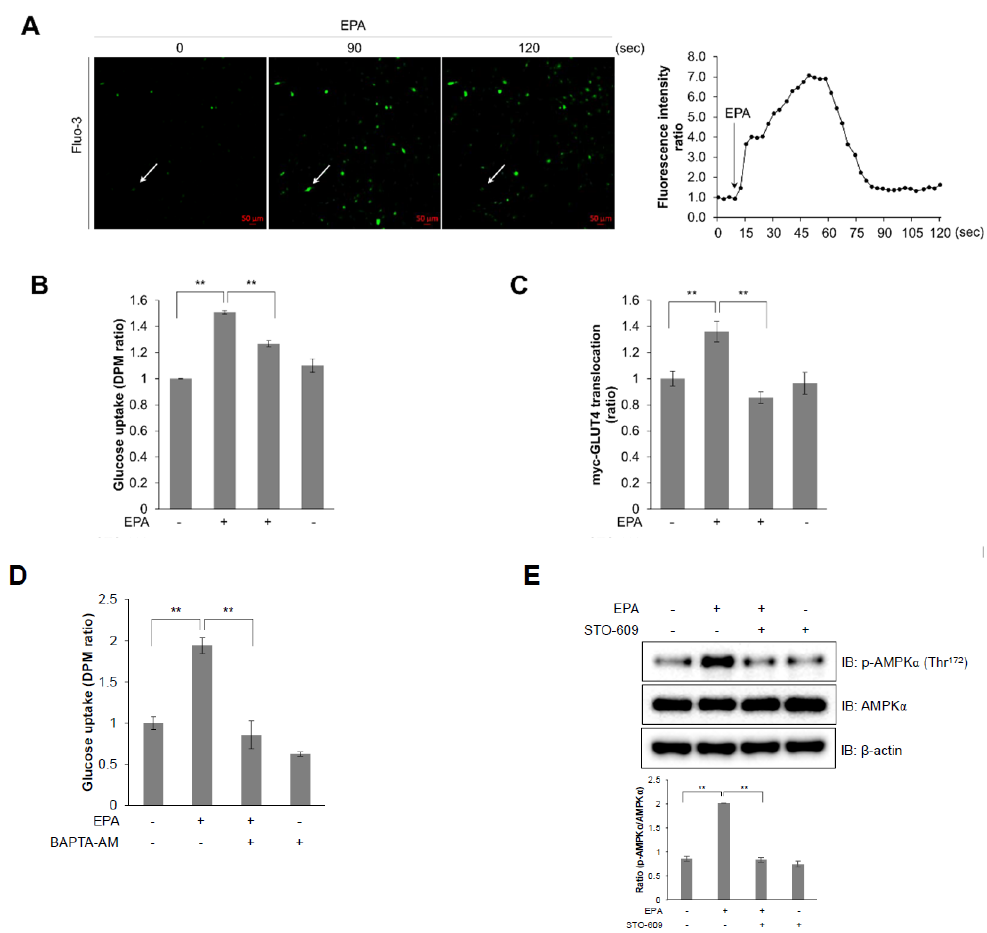
Figure 3. Intracellular calcium plays as an upstream of AMPK in EPA-mediated glucose uptake in skeletal muscle cells. ( A ) C2C12 cells pre-treated with fluo-3 AM for 30 min, and then treated with EPA. ( B ) Uptake of 2-DG in di ff erentiated L6 myotubes pre-treated with STO-609 (5 µ M) and incubated with EPA for 3 h. ( C ) Di ff erentiated L6-GLUT4-myc cells were pre-treated with STO-609, and incubated with EPA for 3 h. ( D ) Uptake of 2-DG in di ff erentiated L6 myotubes treated with BAPTA-AM (25 µ M), and incubated with EPA for 3 h. ( E ) Western blot analysis of cell lysates from C2C12 cells pre-treated with 5 µ M STO-609 for 30 min, and incubated with EPA. ** p < 0.01 compared to untreated cells. Results from three independently replicated experiments are presented.